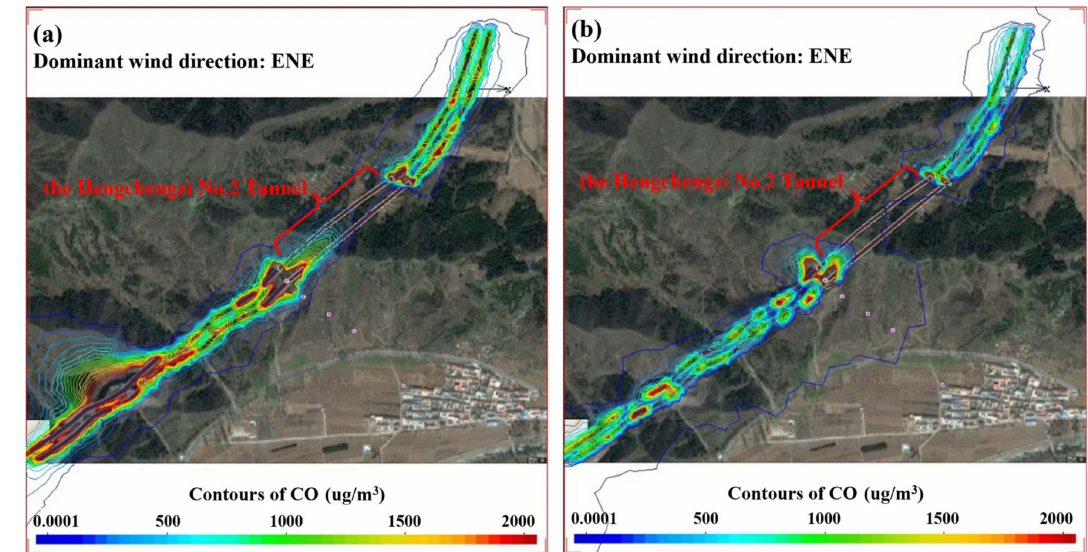
Figure 11. Winter and annual average concentration distribution of CO in the Hengchengzi No. 2 Tunnel section. ( a ) Average concentration distribution in winter; ( b ) Annual average concentration